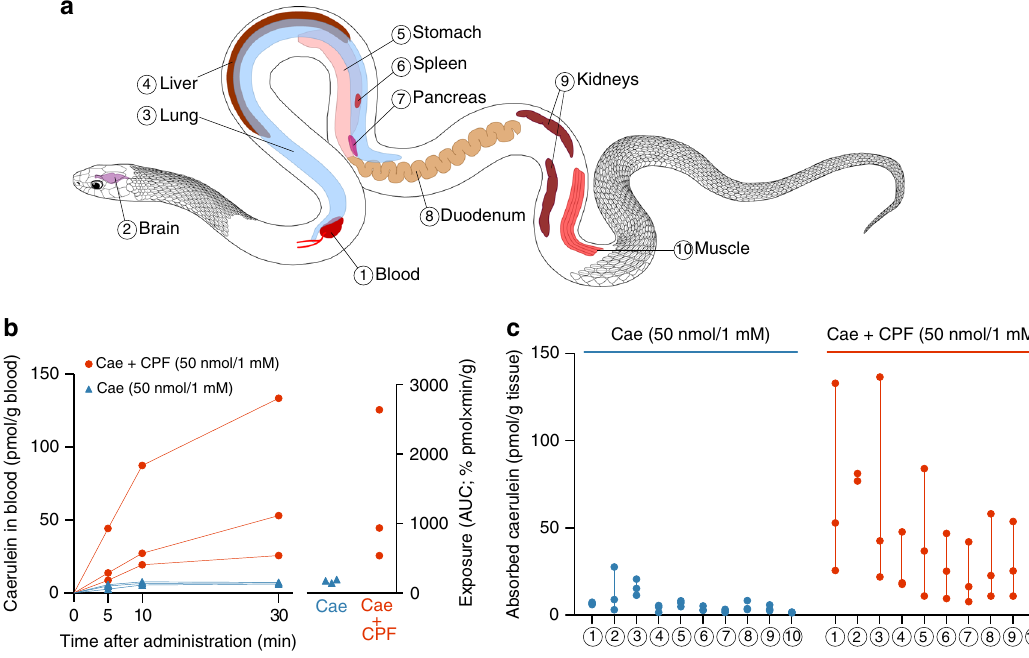
Fig. 2 AMP co-administration accelerates toxin absorption in a live predator. a Investigated organs and tissues in the model predator Thamnophis eques ; numbers are cross-referenced in b and c . b Caerulein (Cae) blood concentrations reach higher levels (left graph), which leads to higher systemic exposure (right graph) when orally co-administered with CPF at 1 mM ( n = 3, linear mixed model, X 2 (1) = 11.4, p < 0.001). c Caerulein levels in organs are higher in snakes when co-administered with CPF after 30 min ( n = 3, linear mixed model, X 2 (1) = 4.7, p = 0.029). Symbols represent individual data values. Linear mixed models are explained in the Methods